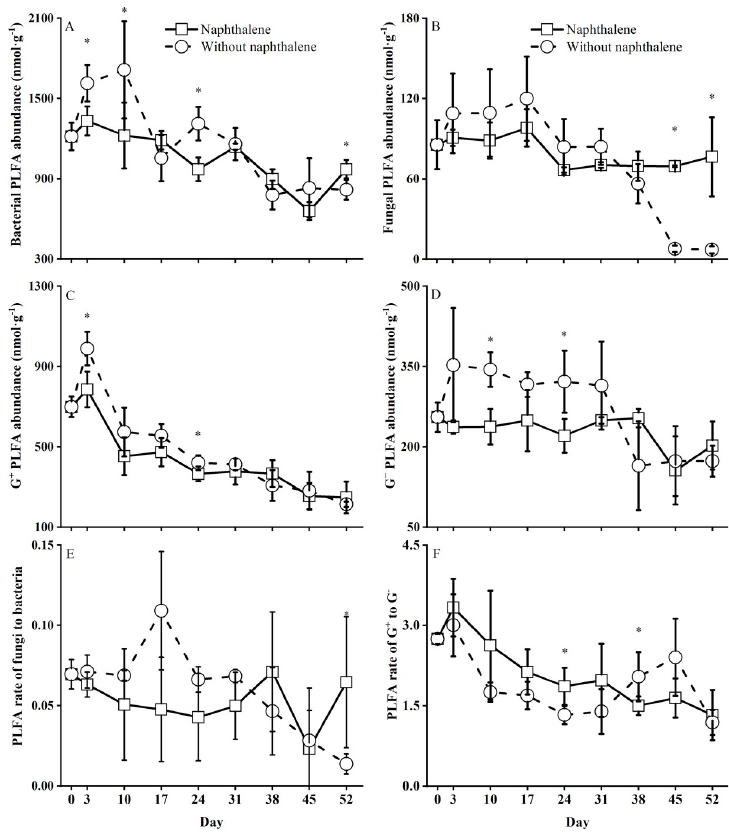
Fig 2. Soil microbial phospholipid fatty acid (PLFA) abundances in subalpine forest soil microcosms treated with and without naphthalene. The values represent the means ± the standard error (SE) (n = 5). Asterisks indicate significant ( � P < 0.05) differences between the treatments with naphthalene and without naphthalene at the same sampling